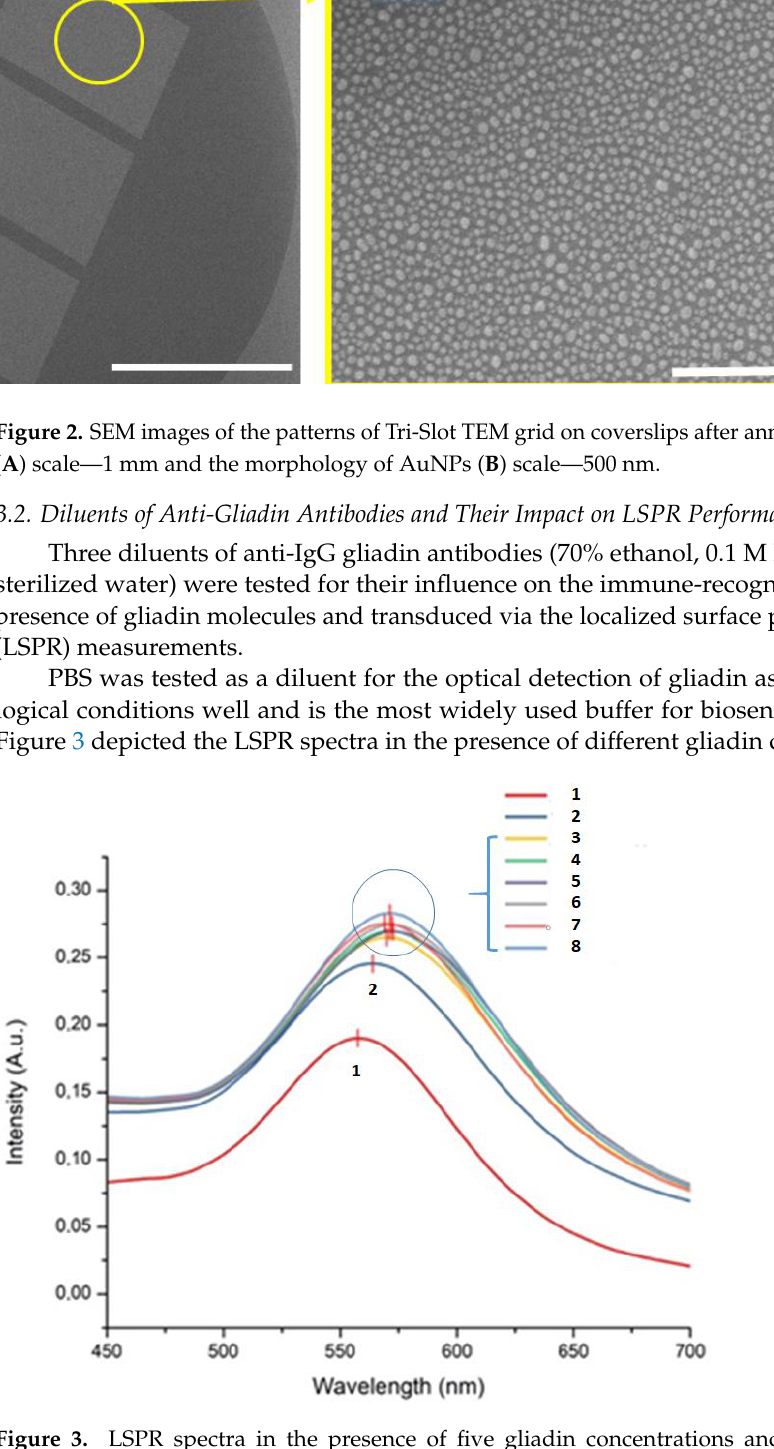
Figure 3. LSPR spectra in the presence of five gliadin concentrations and anti-IgG antibody in PBS buffer for biofunctionalization of metallic nanostructures: (1) annealed 4 nm AuNPs; (2) MUA/AuNPs; (3) anti-gliadin/MUA/AuNPs; (4) 0.1 ppm gliadin; (5) 1 ppm gliadin; (6) 10 ppm gliadin; (7) 100 ppm gliadin; (8) 1000 ppm gliadin. (A.u.—absorbance